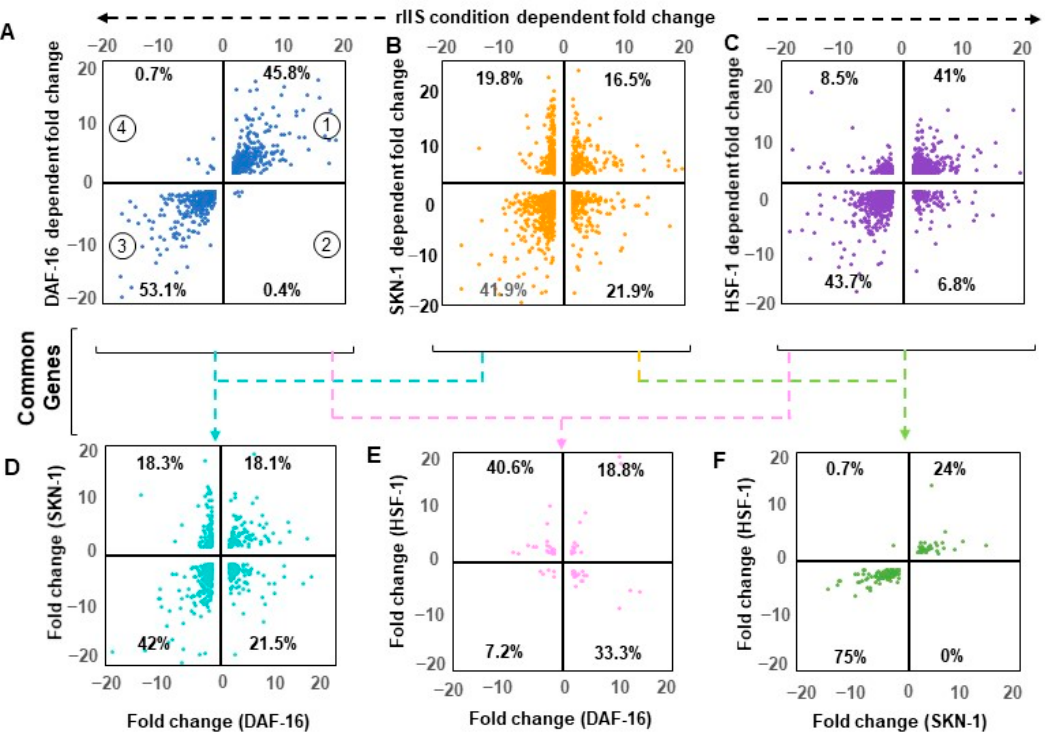
Figure 4. A combinatorial pattern of gene regulation. Quadrant scatter plot depicts all four possible combinations between fold change of activated and repressed genes in two different conditions. Only common genes were considered for analysis. Percentage in each quarter represents the fraction of the total common genes between compared conditions. The upper panel represents a pattern of transcription factor-regulated genes with reduced insulin signaling. Almost all DAF-16 regulated genes partner together with rIIS-dependent genes ( A ). Similarly, most of the HSF-1-regulated genes also aligned with the rIIS condition ( C ), but the SKN-1-regulated genes indicated a mixed pattern ( B ). In the lower panel, common genes between transcription factors under rIIS were considered for analysis (please refer to Figure A6 for detailed analysis). The majority (60%, quarter 1 and 3) of the SKN-1-dependent genes partner together with DAF-16 ( D ), while most of the HSF-1-regulated genes (74%, quarter 2 and 4) behave oppositely to DAF-16 ( E ). SKN-1 and HSF-1 regulate most of their common genes (99%) in the same manner ( F ).